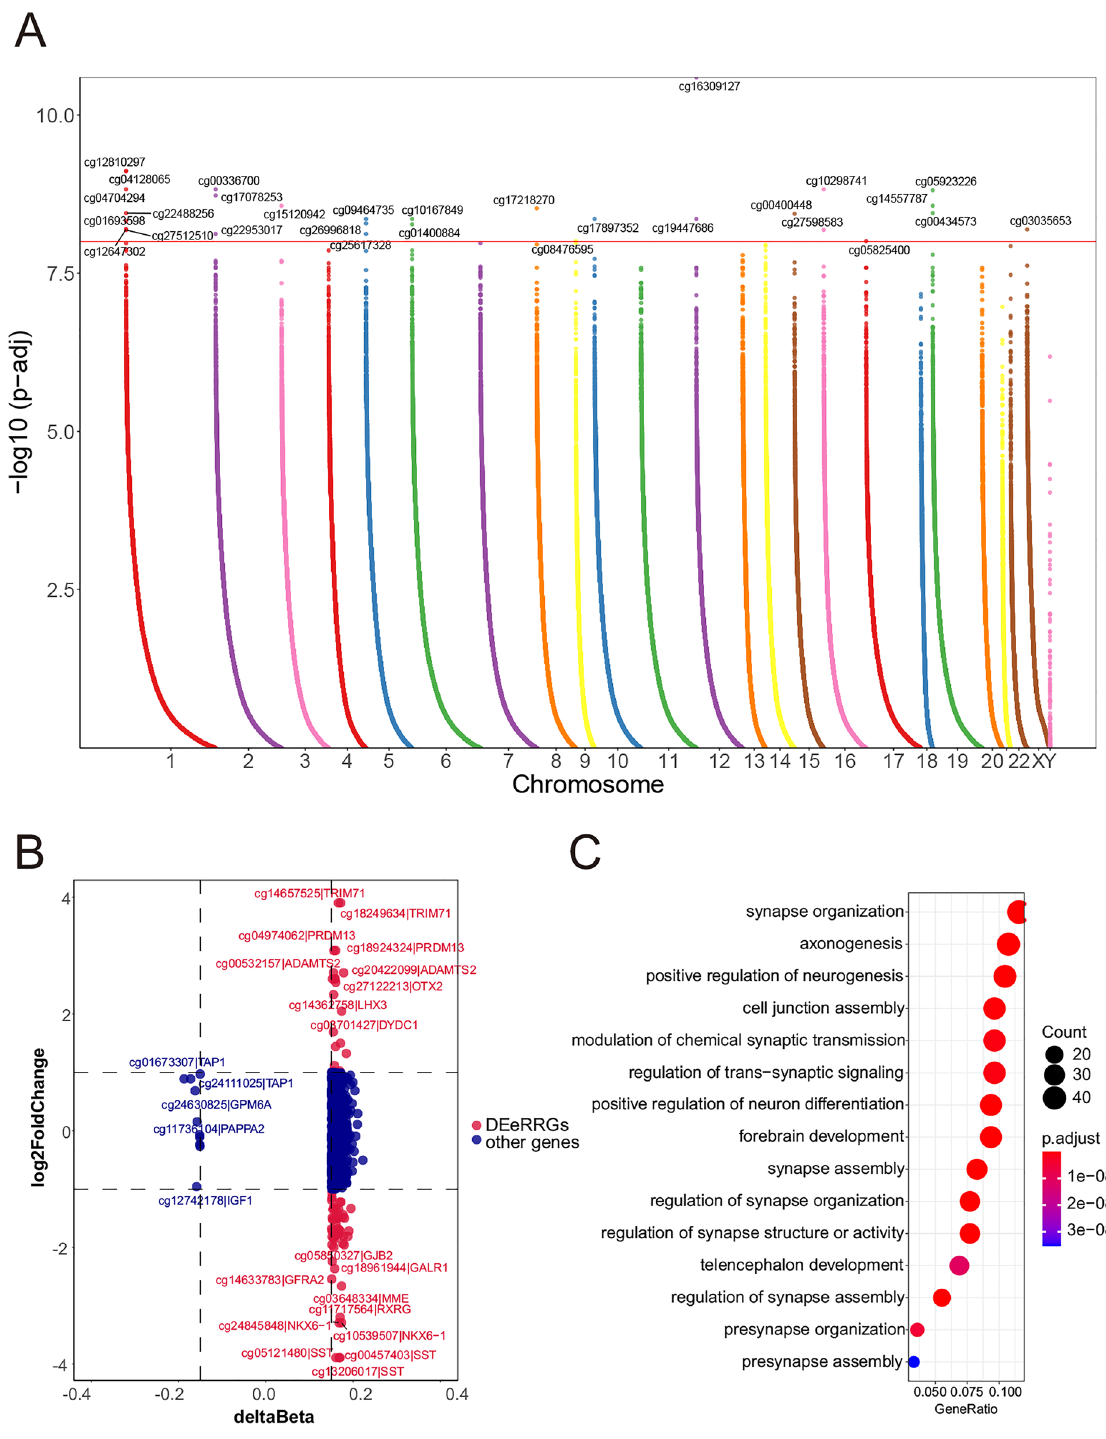
Figure 6. The difference of DNA methylation between high-risk group and low-risk group. ( A ) Manhattan plot of the differentially methylated probes in high-risk group and low-risk group. ( B ) The relationship between expression of eRRGs and DNA methylation level. The red nodes denote the DEeRRGs with Δβ > 0.15. ( C ) The bubble plots show the functional enrichment analyses of DMP-associated